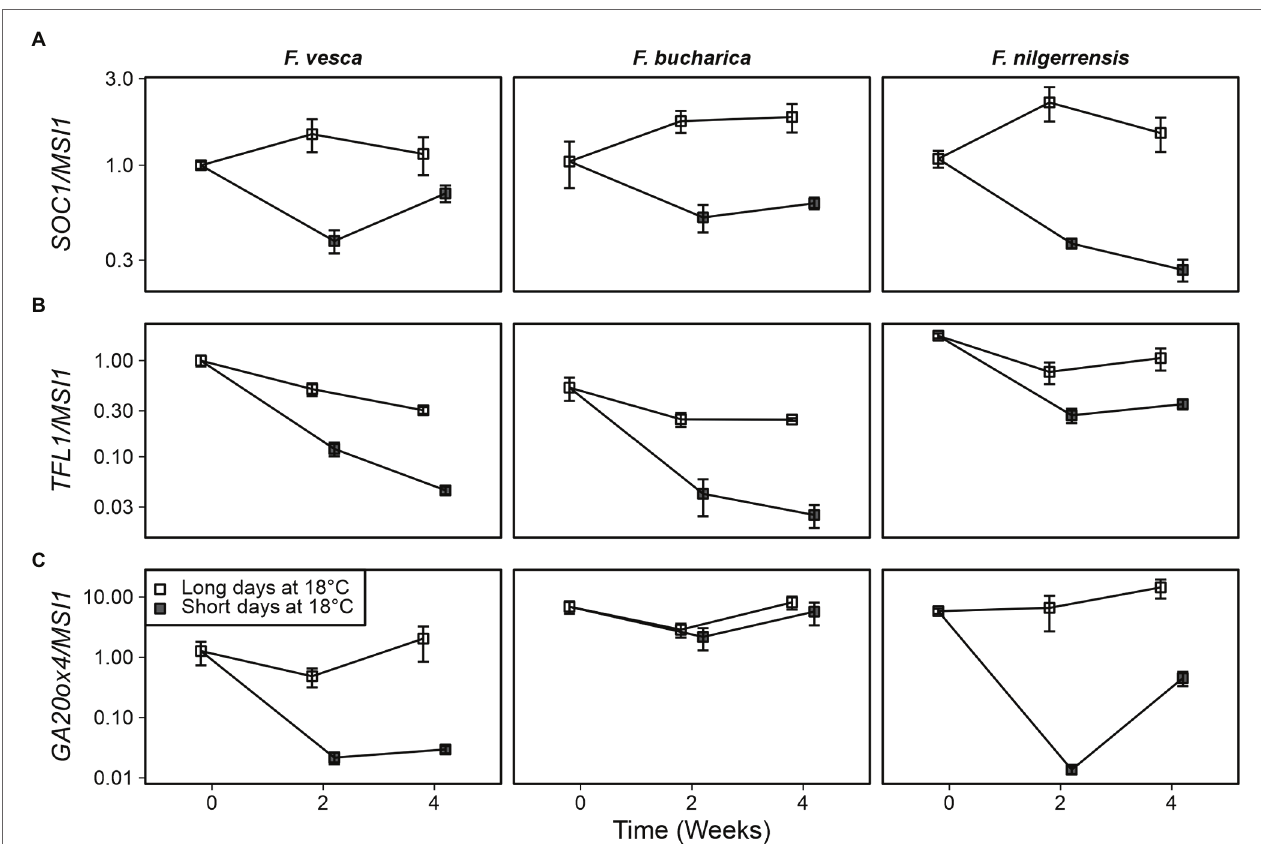
FIGURE 4 | Gene expression patterns in three diploid strawberry species grown under SDs or LDs at 18 ° C. SUPPRESSOR OF OVEREXPRESSION OF CONSTANS1 ( SOC1 ) (A) , TERMINAL FLOWER1 ( TFL1 ) (B) , and GIBBERELLIN 20-OXIDASE4 (GA20ox4) expression (C) in shoot apical samples is shown. Stolon- propagated plants were grown in LDs (18-h) or SDs (12-h) at 18 ° C, and shoot apical samples were collected at the beginning of the treatments, and 2 and 4 weeks later. Week 0, Fragaria vesca samples were used as a calibrator for relative expression analysis. Error bars represent the SEM ( n =